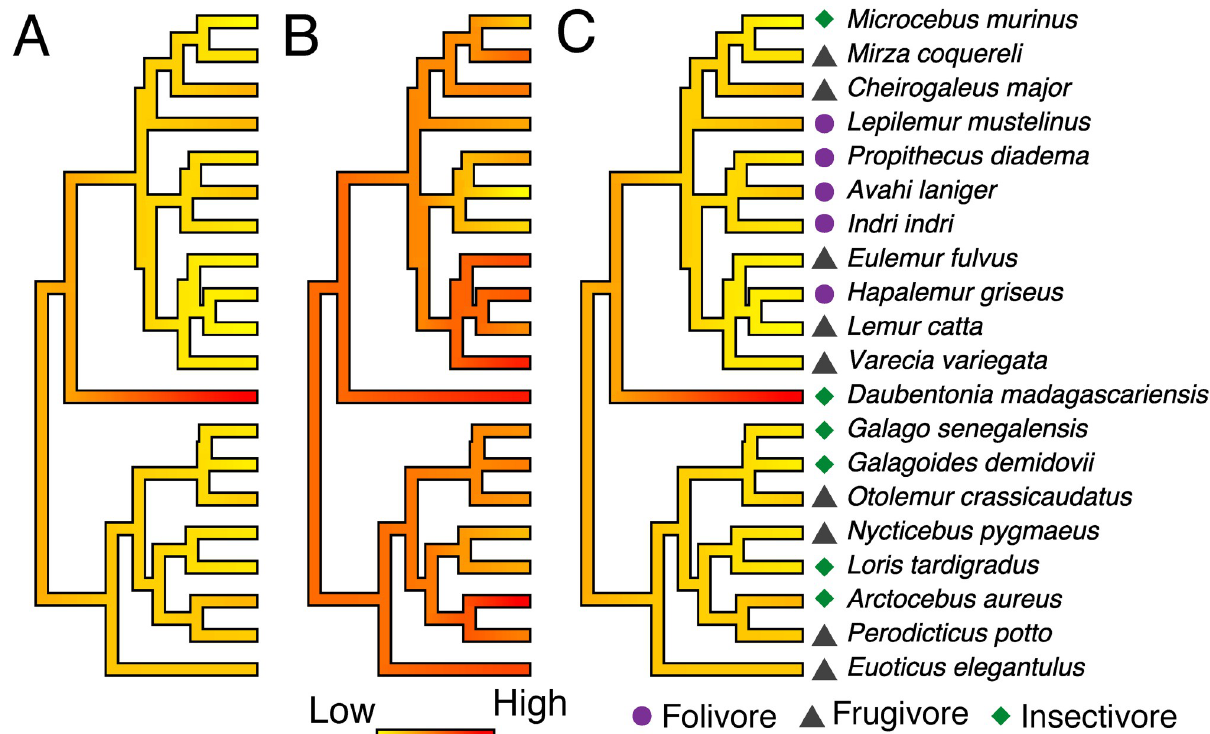
Fig 2. Per-species rates of phenotypic evolution based on phylogenetic ridge regressions for brain shape (A), brain size (B) and dental morphology (C). Symbols represent dietary guilds.